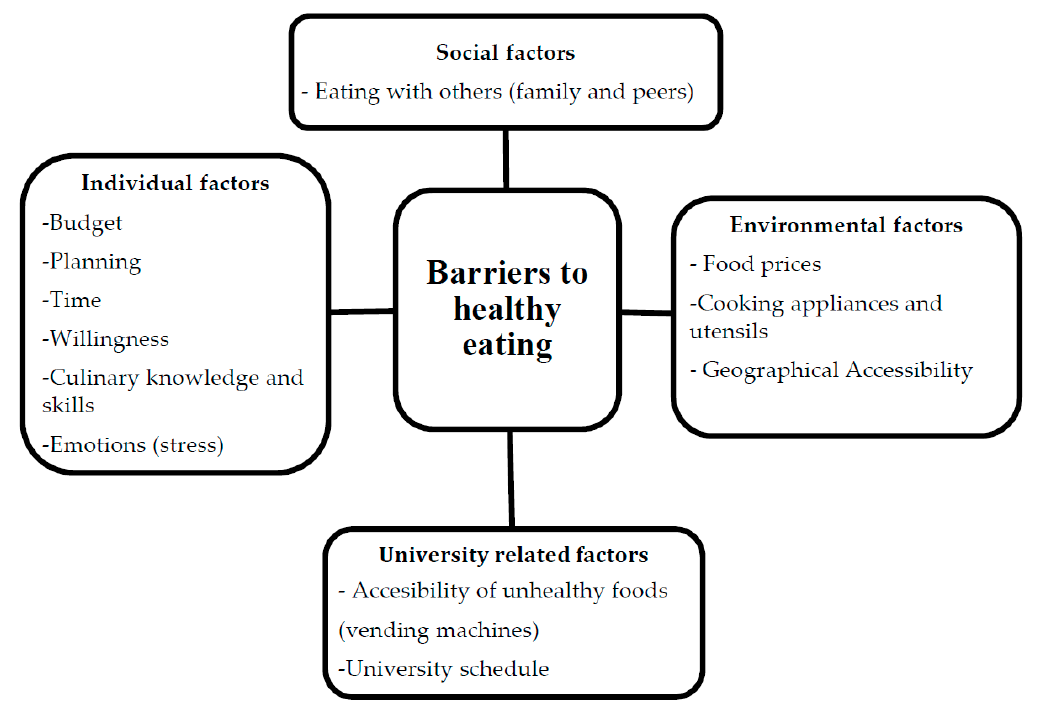
Figure 2. Perceived barriers to healthy eating among university students.